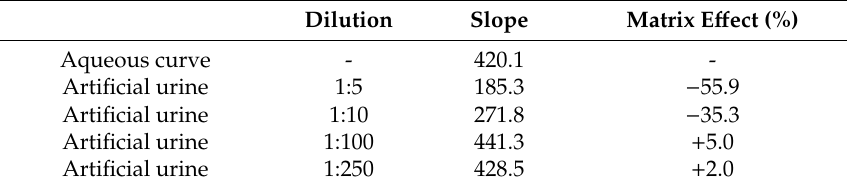
Table 3. Matrix e ff ect using artificial urine (250–2000 nmol · L − 1